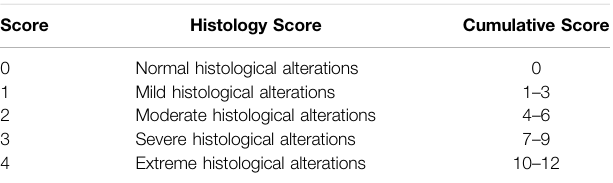
TABLE 2 | Cumulative histology activity